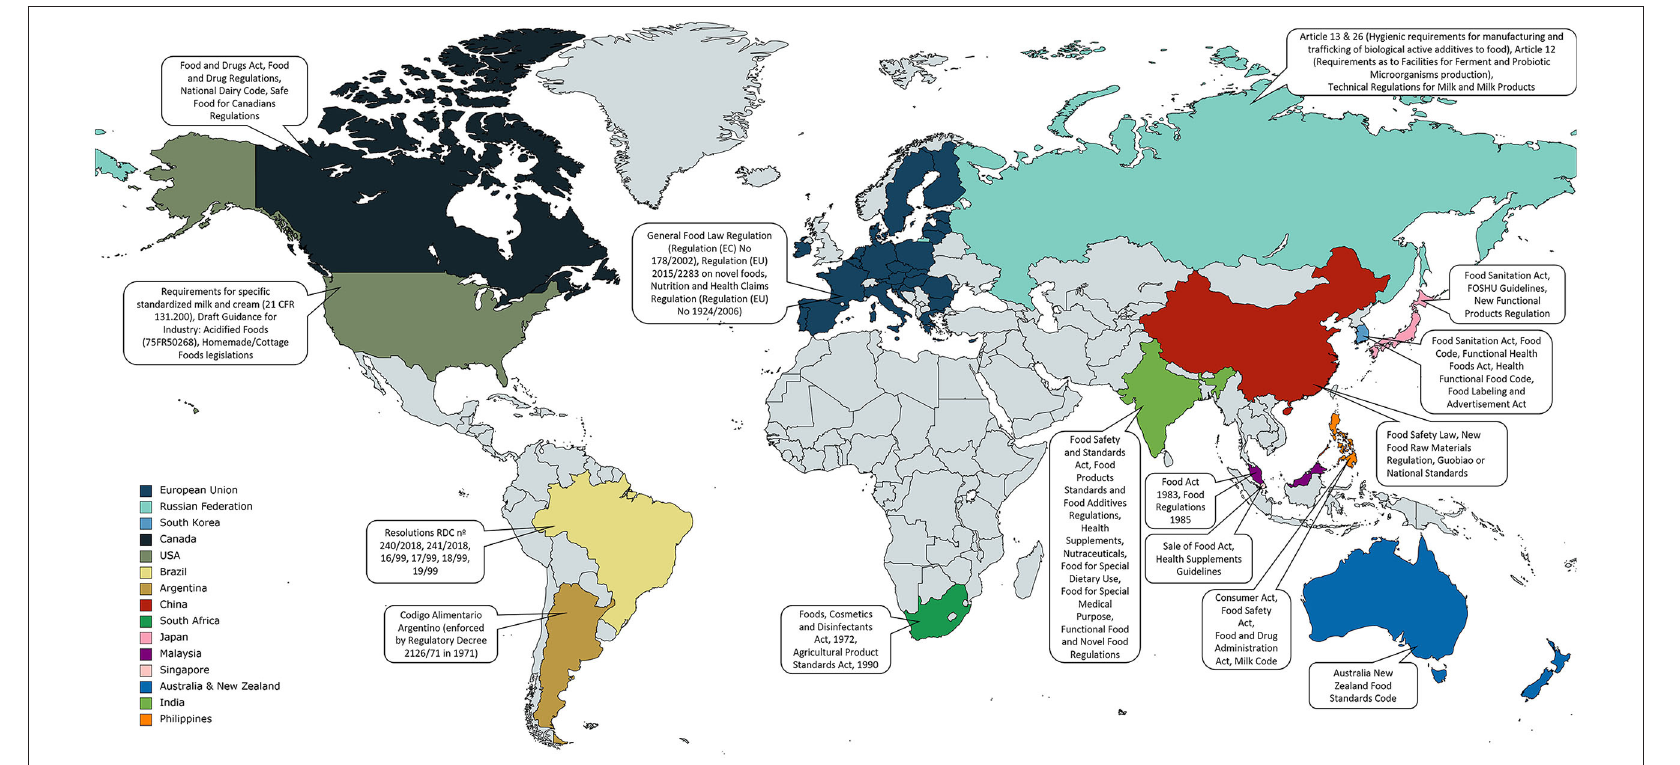
FIGURE 1 | Global regulations for fermented foods. A selection of important regulations in relation to fermented foods is presented here. Countries are color-coded with pertinent regulations mentioned in linked callouts. This is not an exhaustive list of relevant regulations for fermented foods for countries shown in the figure. For more information of such regulations refer to the text and Supplementary Table 1 . The figure was made using the open source, free-to-use online tool MapChart available at